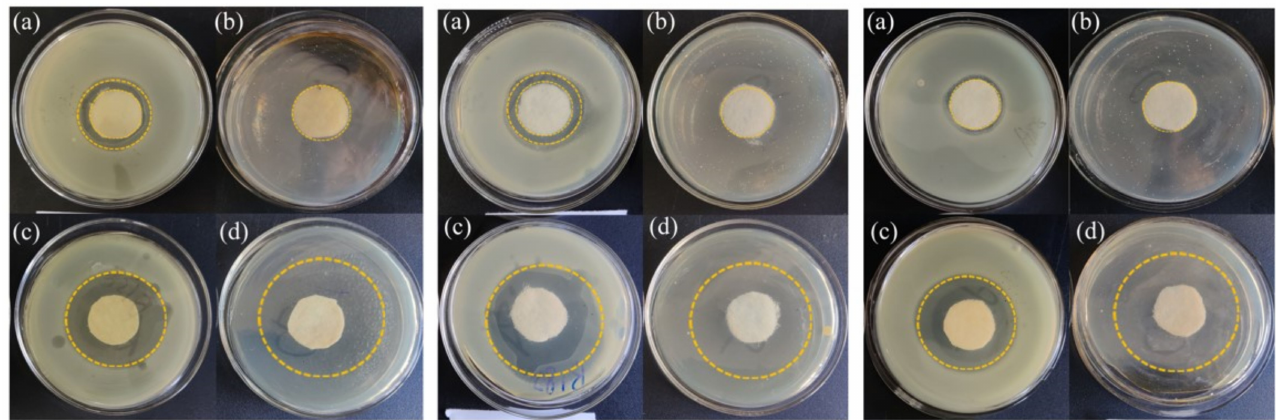
Figure 4. Typical bacteriostatic bands of GF, NF and CF treated with triclosan ( Left : ( a )-GF (AT) against E. coli ; ( b )-GF (AT) against S. albus ; ( c )-GF (TT) against E. coli ; ( d )-GF (TT) against S. albus ; Middle : ( a )-NF (AT) against E. coli ; ( b )-NF (AT) against S. albus ; ( c )-NF (TT) against E. coli ; ( d )-NF (TT) against S. albus ; Right : ( a )-CF (AT) against E. coli ; ( b )-CF (AT) against S. albus ; ( c )-CF (TT) against E. coli ; ( d )-CF (TT) against S. albus ).